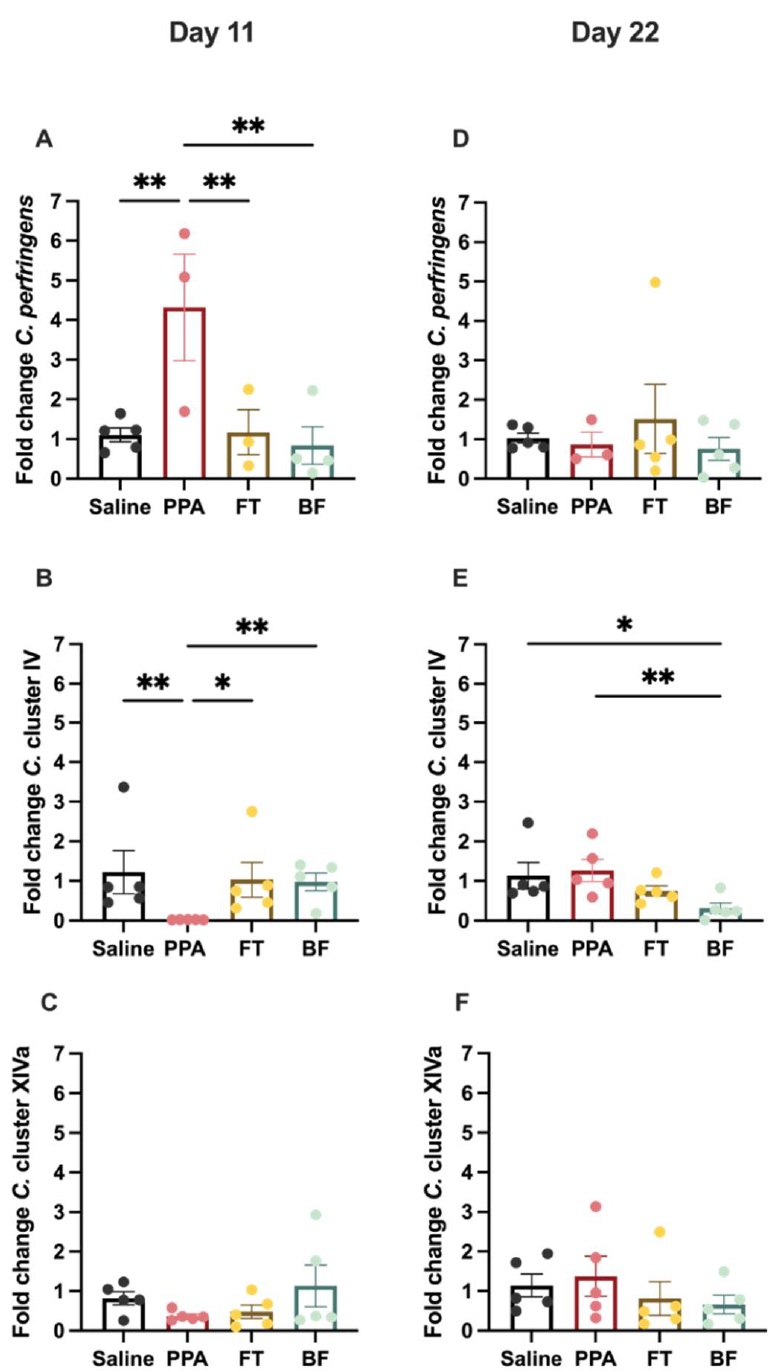
Figure 3. Levels of fecal Clostridium bacteria following saline ( n = 5) and propionic acid (PPA) ( n = 3–5) treatments, and fecal transplant (FT) ( n = 3–5) and Bifidobacterium (BF) ( n = 4–5) interventions at day 11 and at the last day of the intervention (day 22): ( A ) Clostridium perfringens ; ( B ) Clostridium cluster IV; ( C ) Clostridium cluster XIVa at 11 days; ( D ) Clostridium perfringens ; ( E ) Clostridium cluster IV; ( F ) Clostridium cluster XIVa at 22 days. Data presented are means ± standard error of 2 − Ct values. Significant one-way ANOVA was followed by multiple comparisons by Fisher’s least significance difference or Kruskal–Wallis followed by uncorrected Dunn’s test. ** p ≤ 0.01, * p ≤ 0.05.